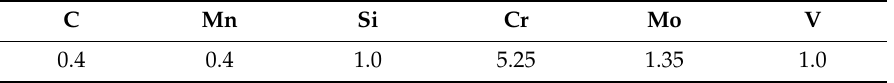
Table 1. Chemical composition of the hot work tool steel (AISI H13), (%).